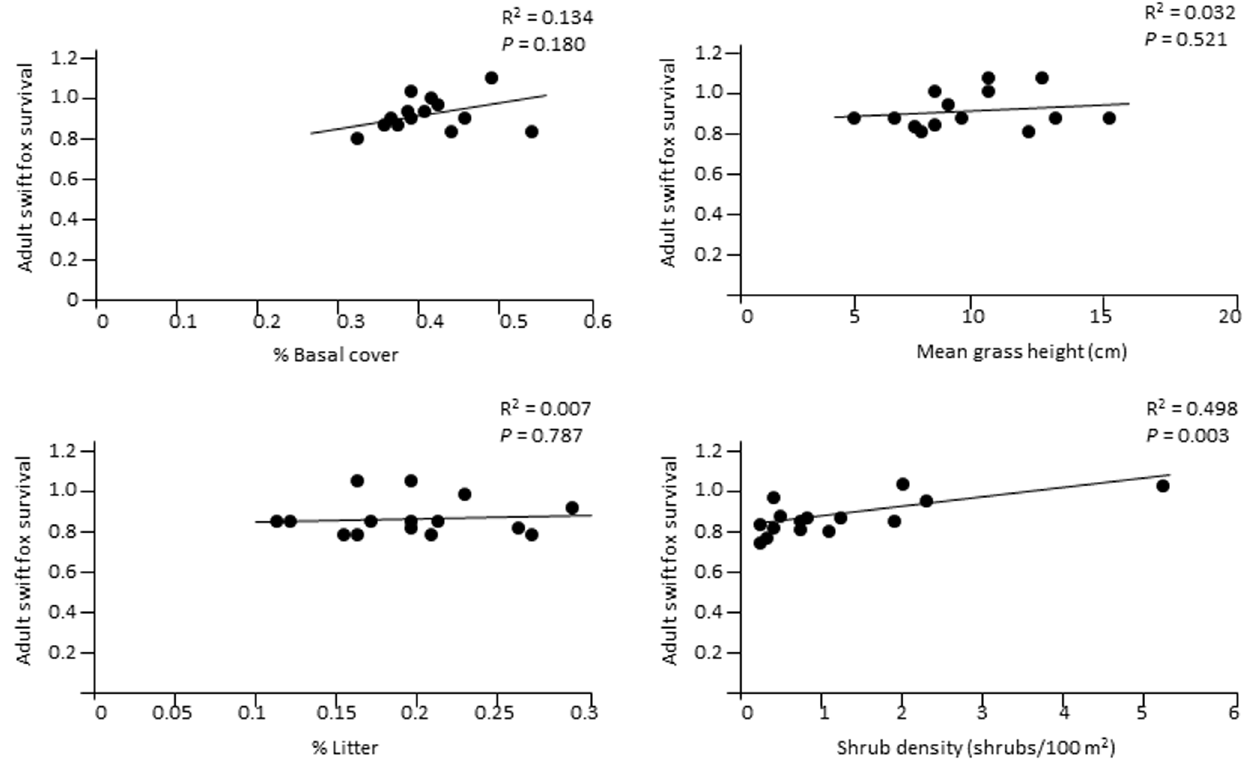
Figure 2. Linear regressions showing the relationships between swift fox survival rates and vegetation structure, southeastern Colorado, USA, 2001–2004.